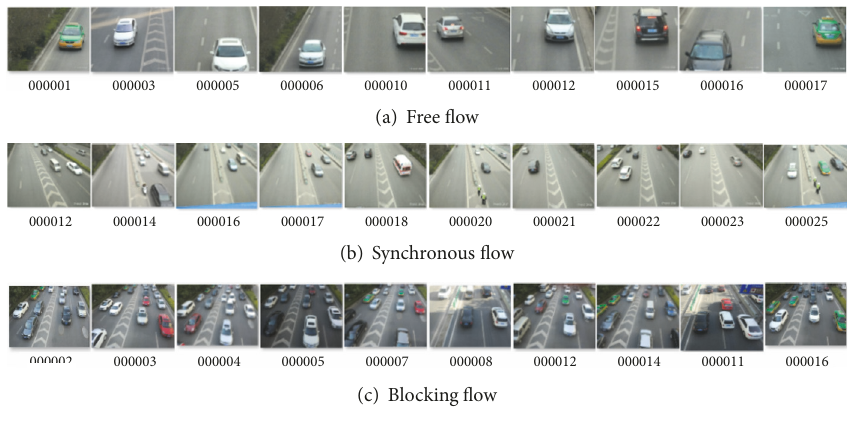
Figure 8: Data samples of different traffic